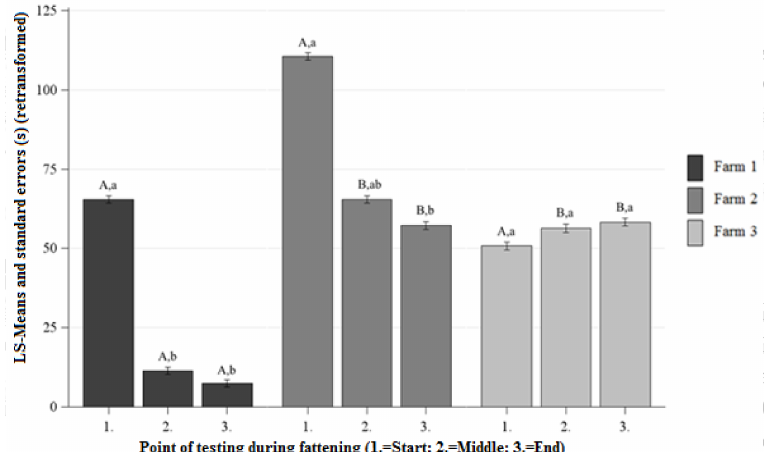
Figure 1. Least squares means-means and standard errors (in seconds) (retransformed) of the approach latency in the human approach test (HAT) at each point of testing; a, b, c letters indicate significant di ff erences within the farm between the di ff erent points of testing ( p < 0.05); A, B, C letters indicate significant di ff erences between the farms within the di ff erent points of testing ( p <